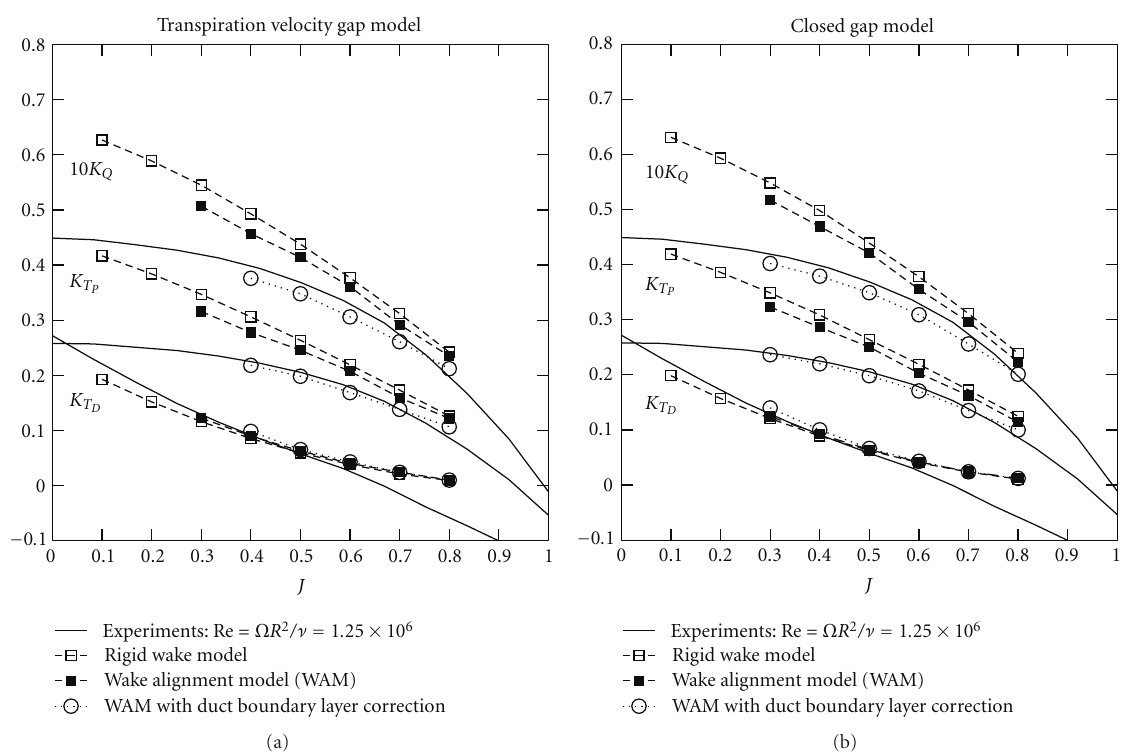
Figure 8: Comparison between predicted thrust and torque coe ffi cients for the Ka4-70 propeller inside duct 19Am. Predictions are presented for the transpiration velocity gap model (a) and the closed gap model